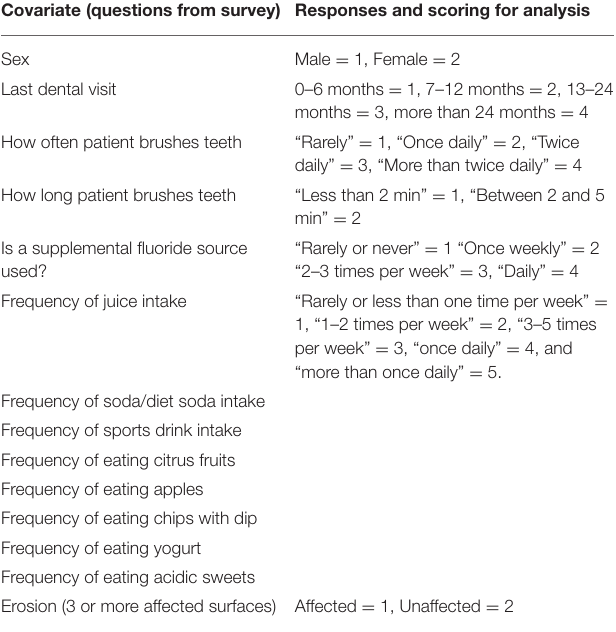
TABLE 2 | Covariates included in each linear regression test. Covariate (questions from survey) Responses and scoring for analysis